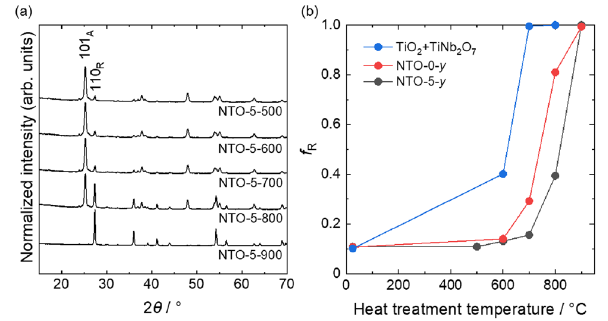
Figure 3. ( a ) XRD patterns of NTO-5- y ( y = 500 − 900). 101 A and 110 R correspond to 101 diffraction peak of anatase and 110 diffraction peak of rutile, respectively. ( b ) Rutile phase weight fraction, f R , against anatase phase calculated from corresponding XRD patterns. As mixed pristine TiO 2 and TiNb 2 O 7 , NTO-0-dry, and NTO-5- dry are plotted at temperature of 25 °C.